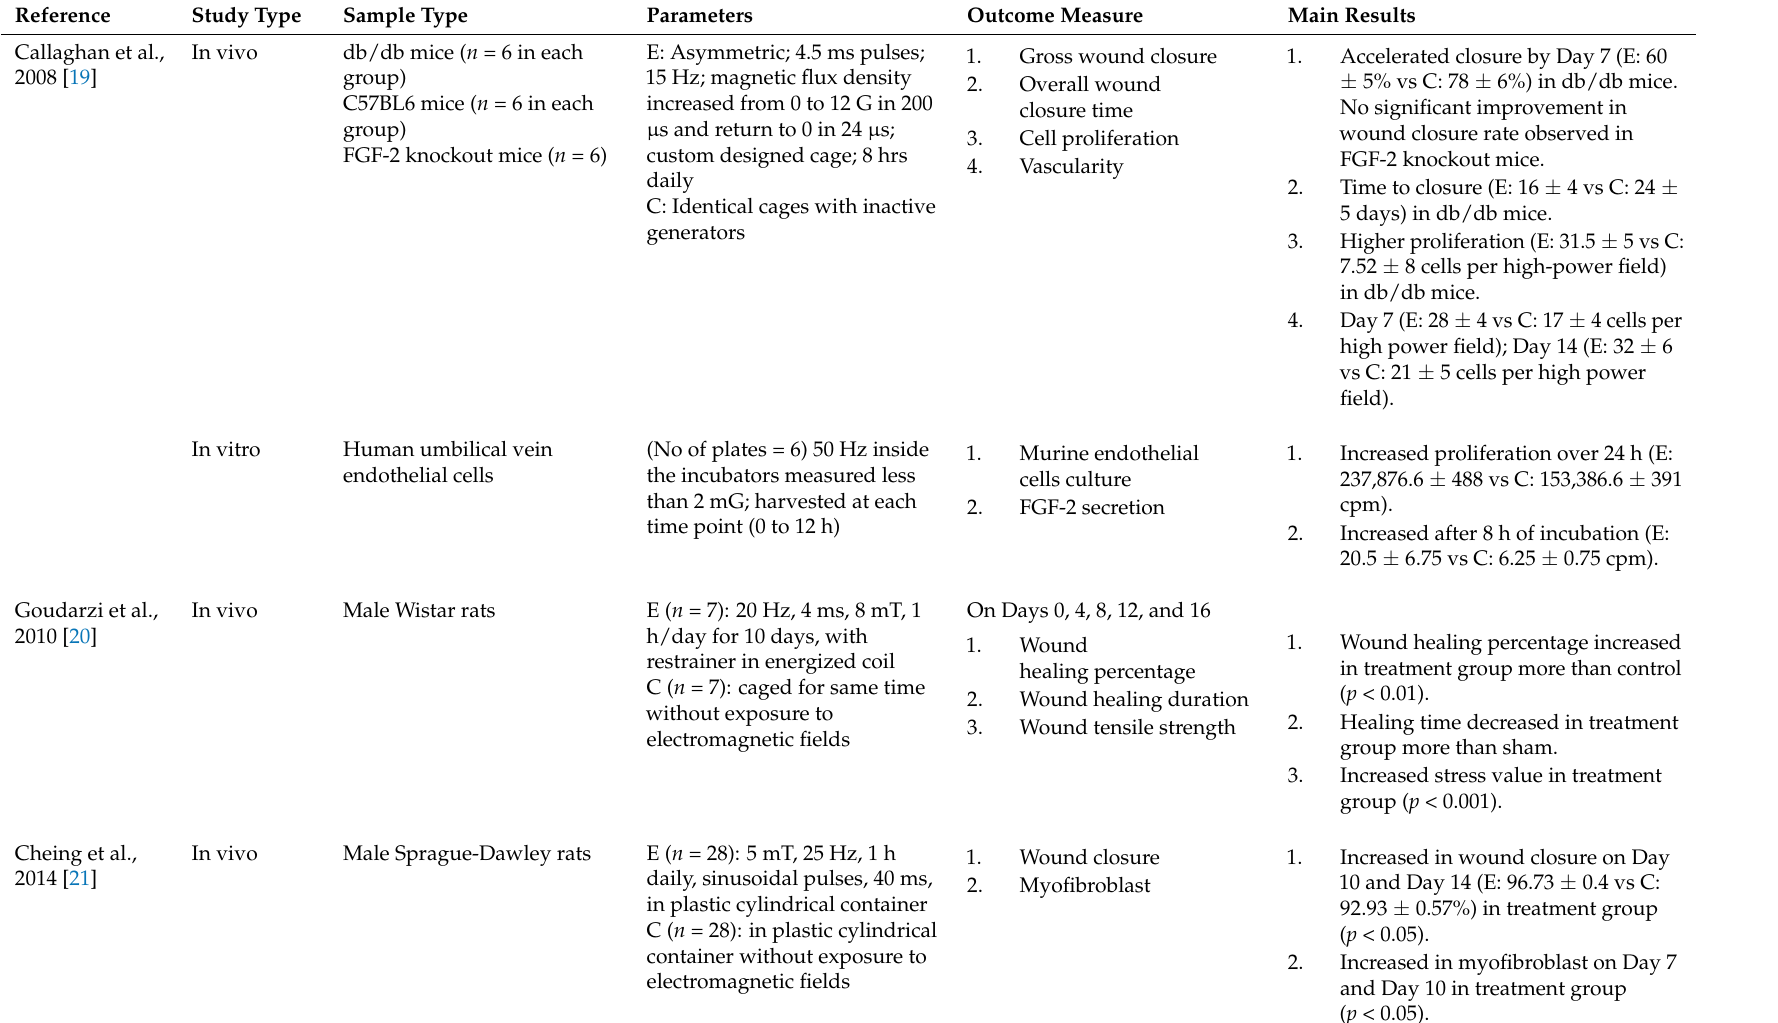
Table 1. Outcomes of PEMF energy for treating diabetic